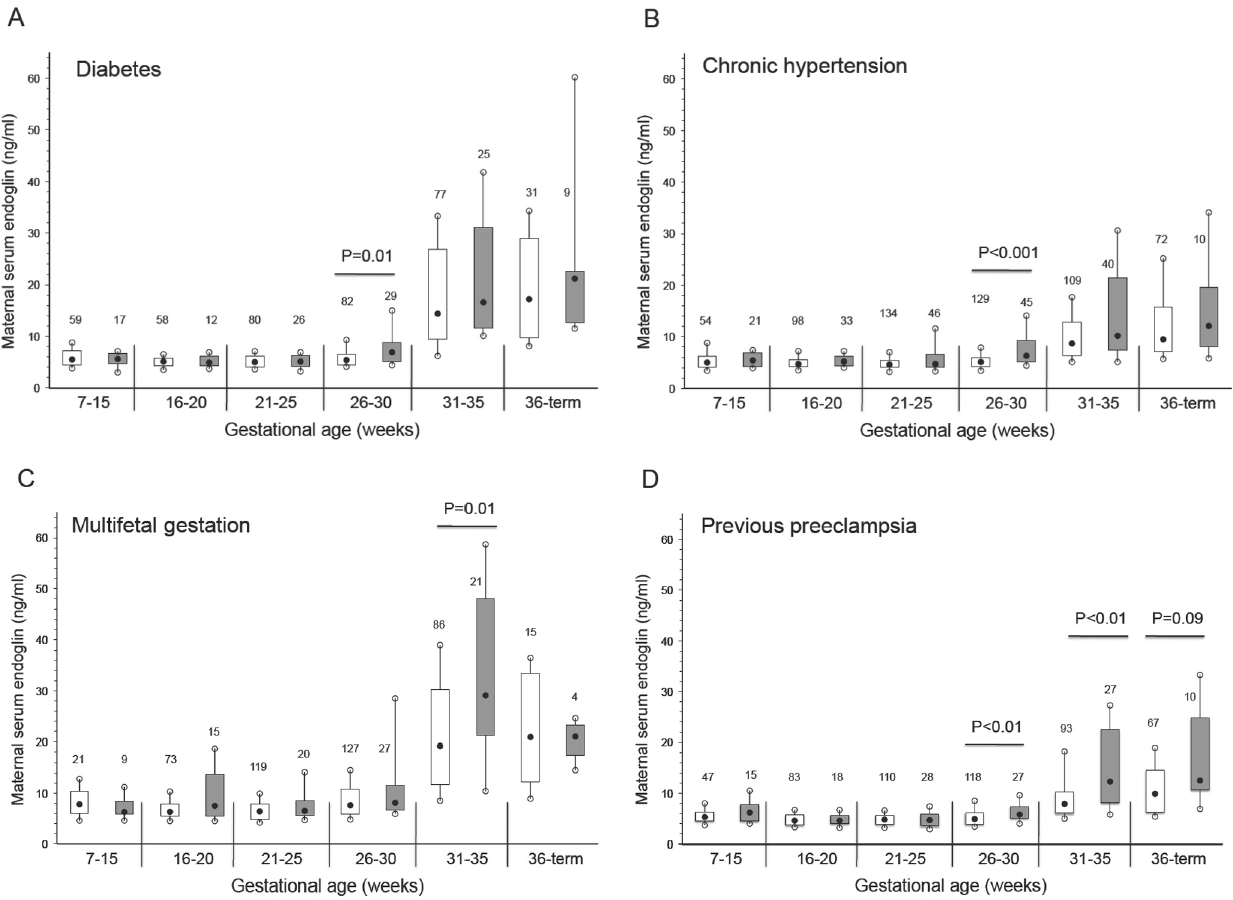
Figure 2. Maternal serum sEng across gestation in women with pre-existing diabetes (A), chronic hypertension (B), multifetal gestation (C), and previous preeclampsia (D). Open boxes are controls and shaded boxes are subjects who developed preeclampsia. The number above each box indicates the number of samples. The filled black circles are the median, the open circles are the 90th and 10th percentiles, and the top and bottom lines of the box are the 75 th and 25 th percentiles of the data for each group. Statistical significance is indicated by p values.